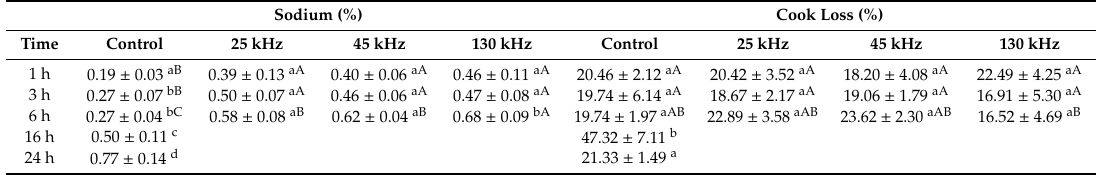
Table 2. Sodium uptake and cook losses: E ff ects of ultrasonic frequencies (25, 45, 130 kHz) on the mineral uptake (g / 100 g of meat) and cook loss of chicken breast marinated for 1, 3 and 6 h. Values for sodium uptake for chicken sample marinated without ultrasound (Control) after 16 and 24 h are also presented. Values represents means ± standard deviation (SD, N = 4). Sodium (%) Cook Loss